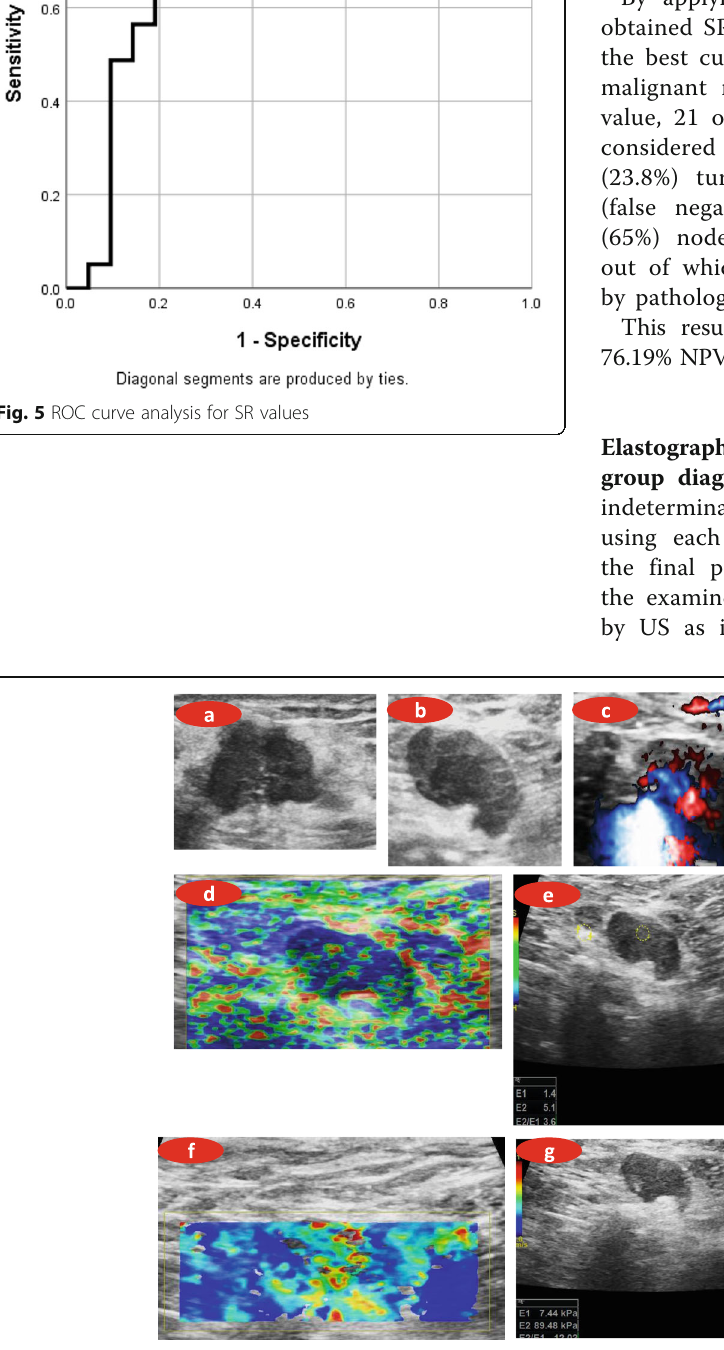
Fig. 6 A pregnant 33-year-old lady presenting with a palpable breast lump